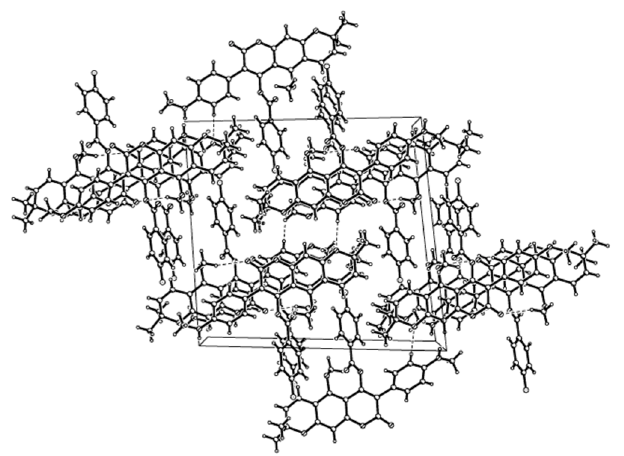
Figure 4. View of the packing compound 2f in the Figure 4 . View of the packing compound 2f in the cell. Figure 4 . View of the packing compound 2f in the cell.